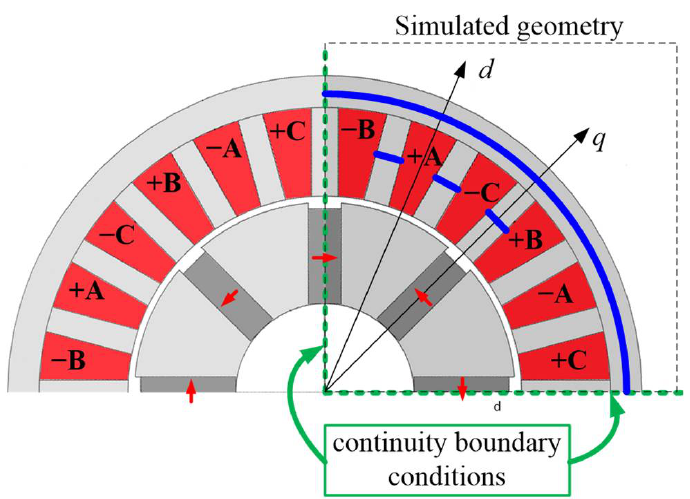
Figure 10. Finite element model of an example geometry representation with the rotor’s q-axis aligned with phase A.